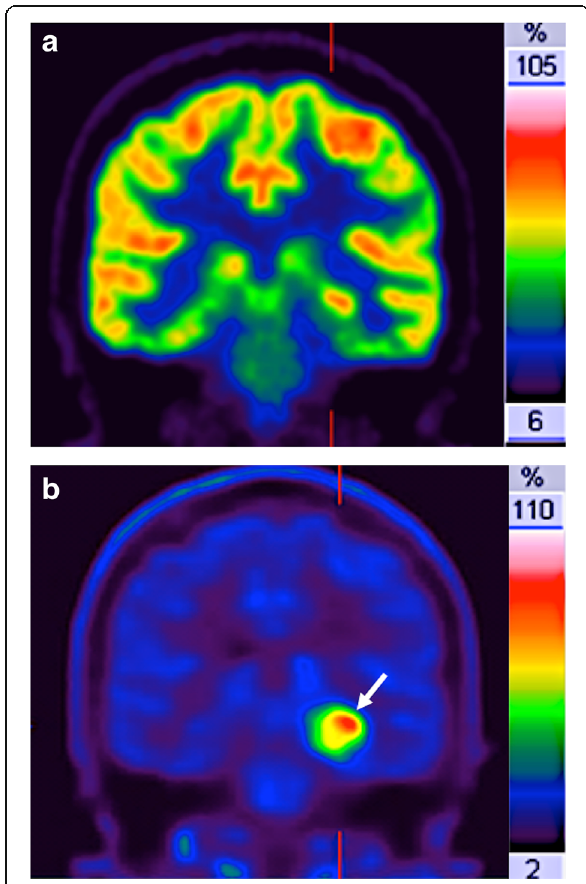
Fig. 15 Relapsing brain astrocitoma (white arrow) in a 54year-old-man. a 18 F-FDG and b 11 C-methionine coronal-reformatted images. Normal uptake of FDG in brain impeded an adequate tumor detection and delineation. However, 11 C-methionine PET clearly depicted the tumor (white